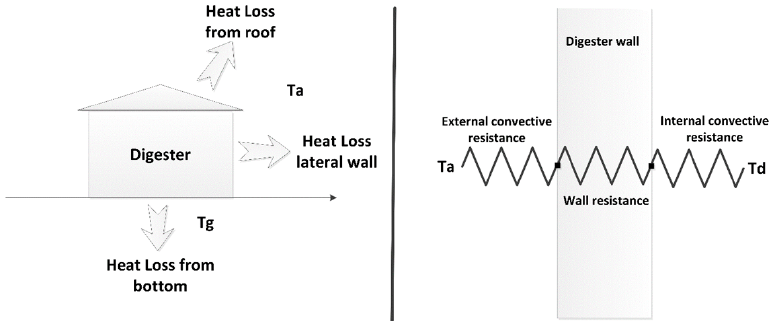
Figure 5. The heat transfer mechanism of the digesters.